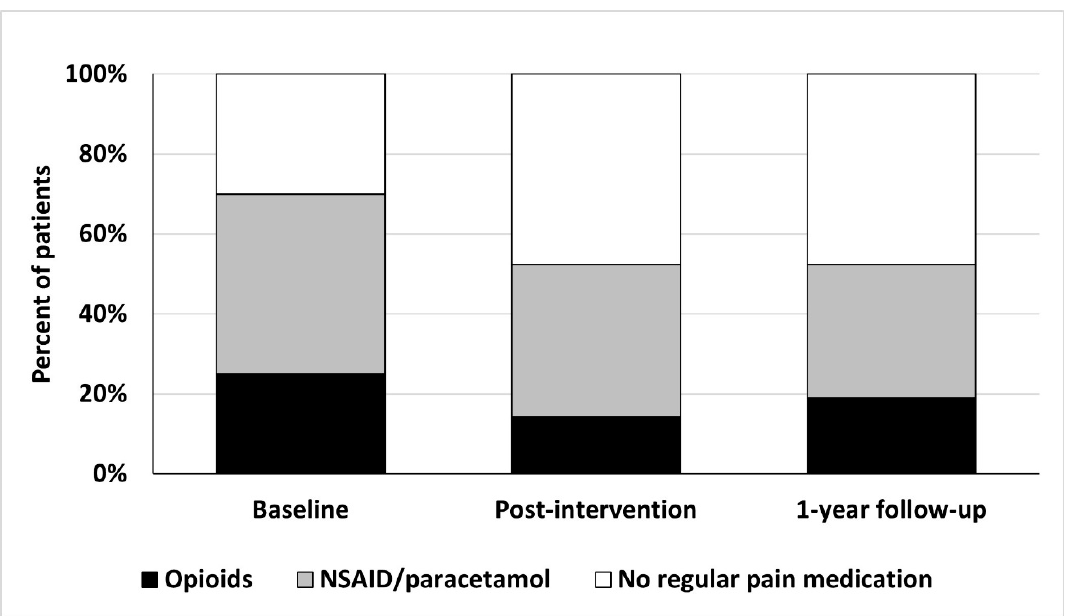
Figure 2. Usage of analgesics during the three different time points. Patients on both opioids and non-steroid anti-inflammatory drugs (NSAID) or paracetamol were included only in the opioid group.